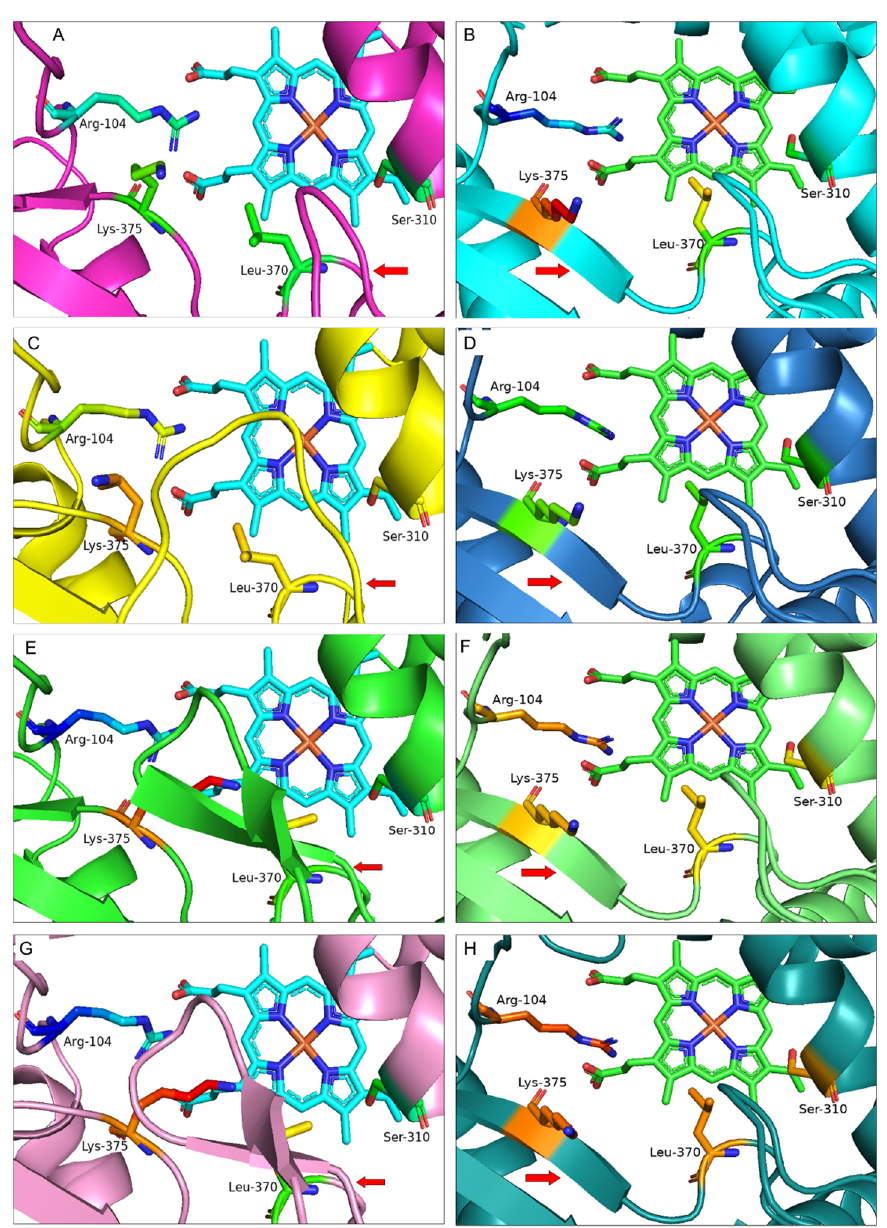
Figure 4. Active site structure of IFS from ( A , B ) G. echinata (BAA76380.1) ( C , D ) M. truncatula (QBF58774.1) ( E , F ) B. vulgaris (AAF34538.1) and ( G , H ) T. pratense (AAP06953.1). Protein models on the left ( A , C , E , G ) are developed using Salvia miltiorrhiza CYP76AH1 (PDB: 5YLW) as a template on the SWISS-MODEL protein structure homology modelling server (https://swissmodel.expasy.org (accessed on 10 April 2022)). Protein models on the right ( B , D , F , H ) are developed on the Alphafold server. Key amino acids are shown as sticks; amino acid numbering is based on the G. echinata amino acid sequence. Red arrows indicate the presence of a long loop in M. truncatula and extra β -hairpin of B. vulgaris and T. pratense compared with the G. echinata protein model and the β 4- sheet present in all models. The presence of an extra β -hairpin in the active site over the Heme unit might control/interfere with the entrance and selection of substrate and may have a role in enzyme